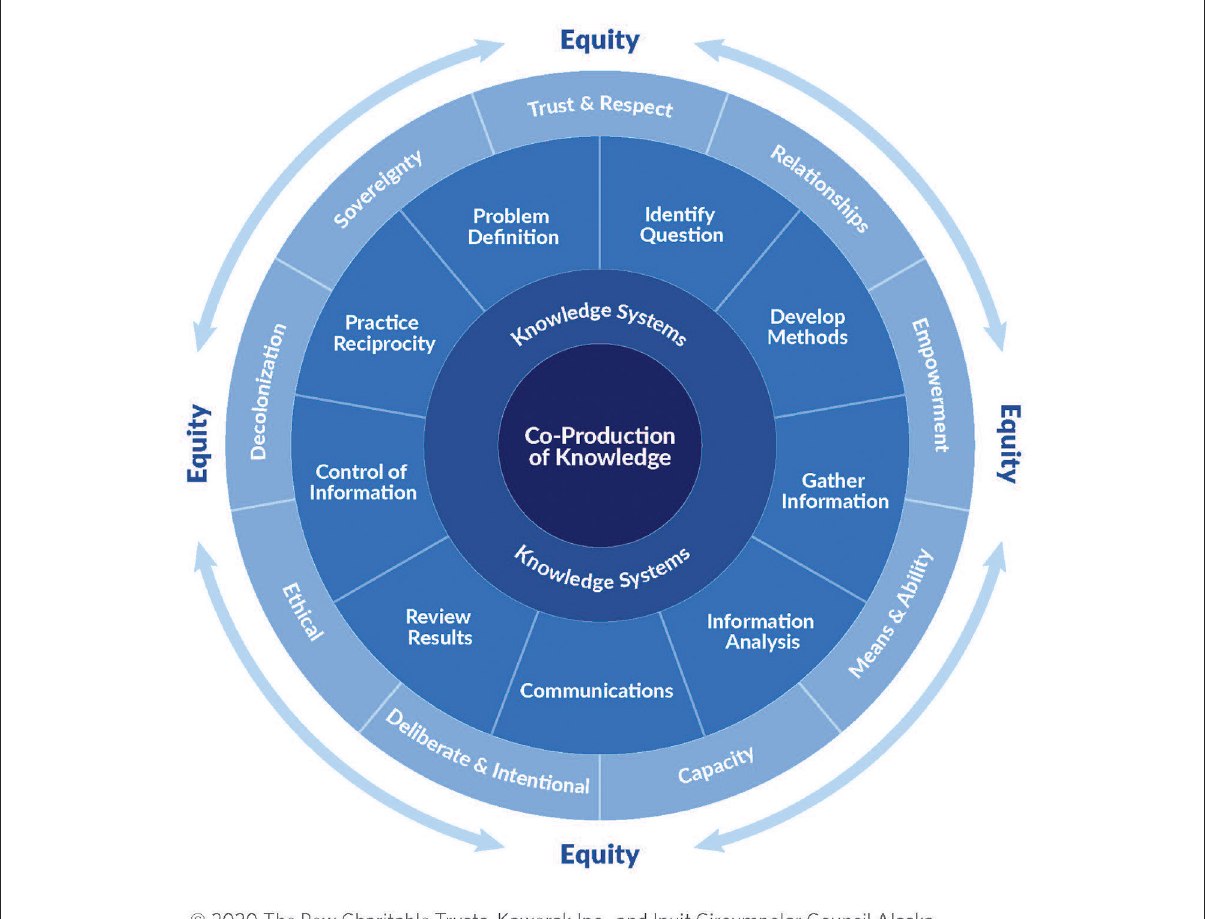
FIGURE1 Reproduced from Yua et al. (2022) depicting a visual representation of the framework for Ellam Yua co-production of knowledge (CPK). Yua et al. (2022) explain: “The center of the framework shows the goal: co-production of knowledge. Surrounding the goal are the two knowledge systems (Indigenous Peoples’ knowledges and science) that will come together in this process. The inner ring surrounding the knowledge systems is what we refer to as the “action circle.” This circle, or inner ring contains various aspects of, or actions that are part of, a CPK research process. We emphasize that CPK is a process. The outer ring of the CPK framework holds all the concepts, referred to as “conceptual tools,” that all participants in this approach need to implement and be continuously mindful of. These tools are the concepts that, when implemented together, can bring about equity. Lack of equity is a systemic issue in many research relationships with Indigenous Peoples. Without equity, a CPK approach is not possible. CPK is an iterative and cyclical process, rather than a simplistically linear approach” (p.